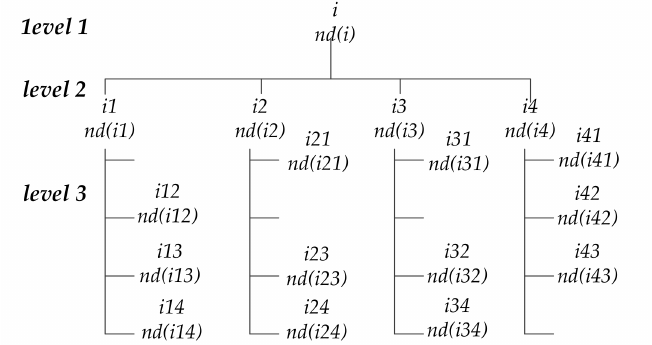
Figure A1. Example of dg-graph